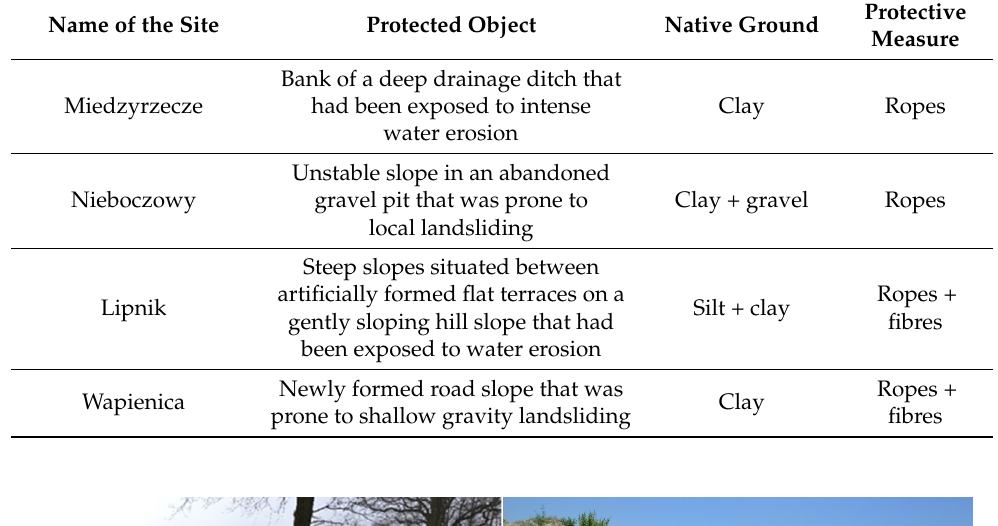
Table 1. The objects that were protected using ropes.